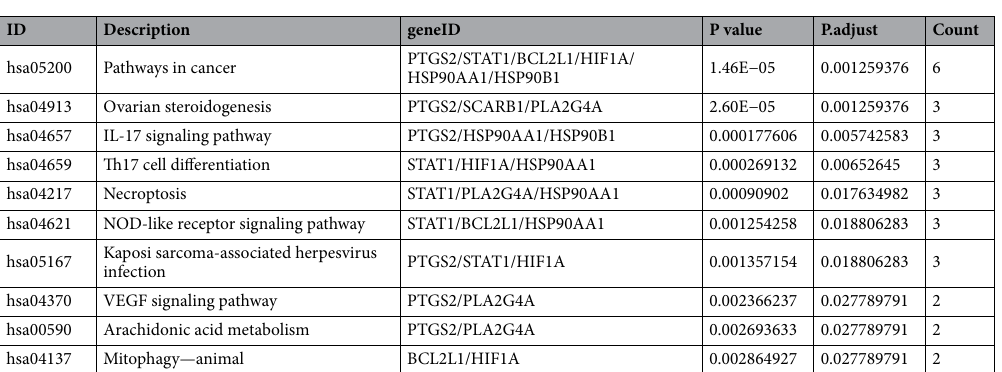
Table 3. KEGG analysis of cross genes in vitiligo patients with COVID-19 treated with AM.